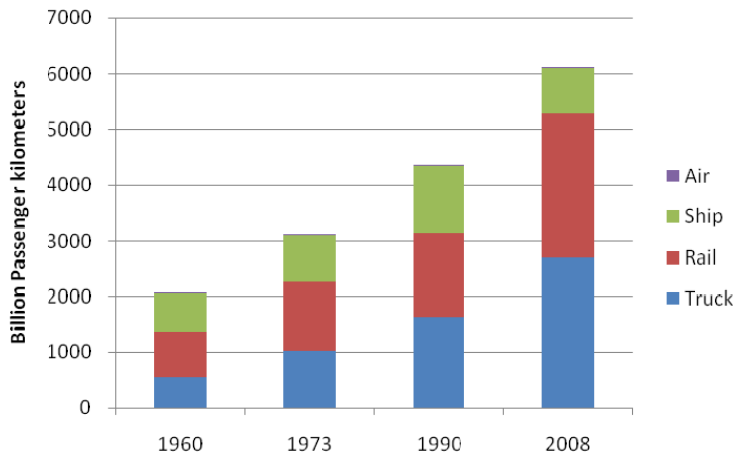
Figure 2. Total Freight Travel by